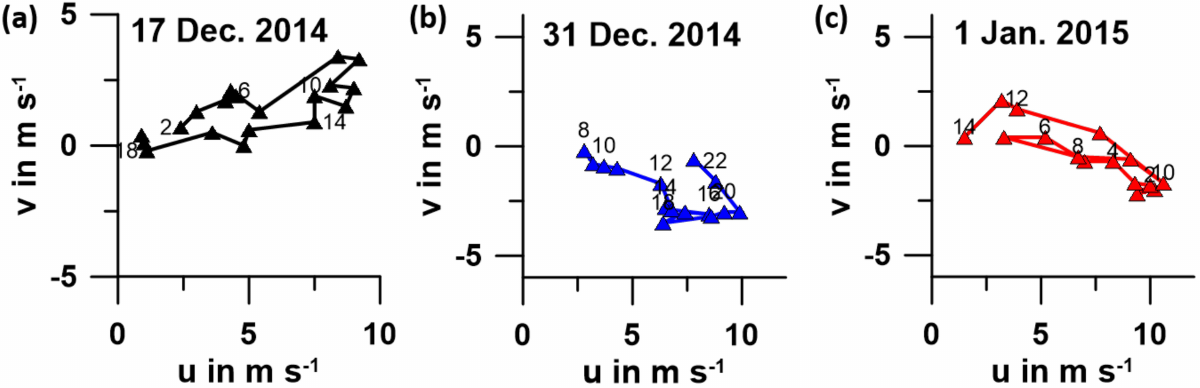
Figure 12. ( a ) Hodograph at the height 100 m for 17 December 2014. ( b ) Hodograph at the height 300 m for 31 December 2014. ( c ) Hodograph at the height 300 m for 1 January 2015. Numbers denote the time in UTC, triangles are plotted for every